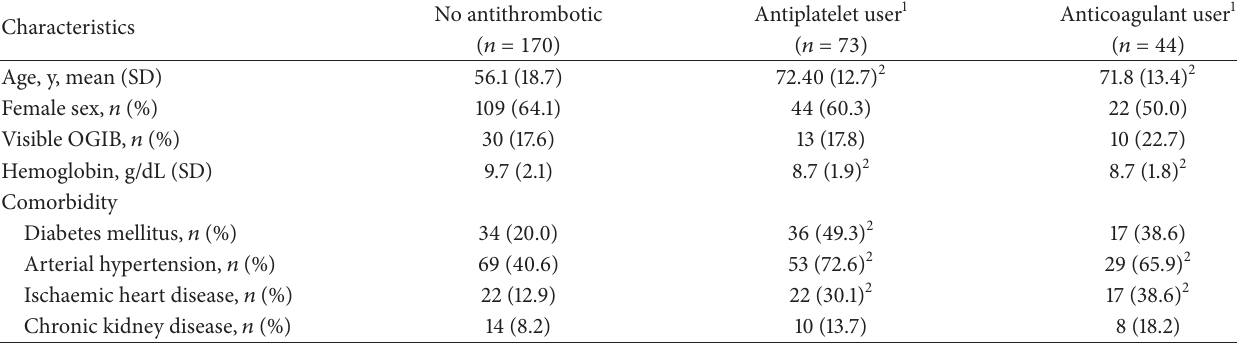
Table 2: Baseline characteristics of patients under antiplatelet and anticoagulant drugs.